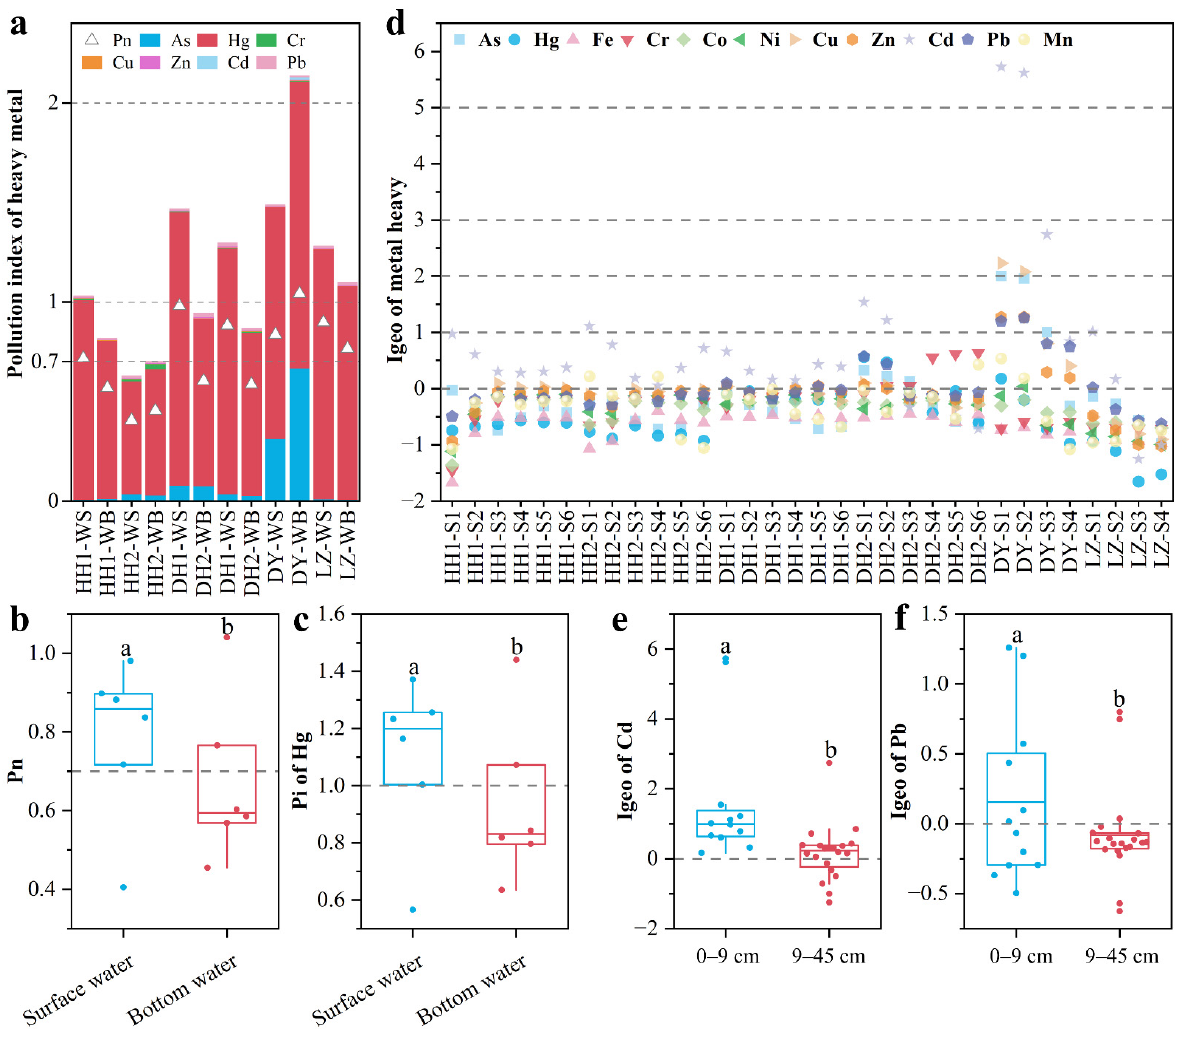
Figure 4. Pollution level of heavy metals: ( a ) pollution level of heavy metals in water columns; difference in P n ( b ) and P i for Hg ( c ) between surface water and bottom water; ( d ) pollution level of heavy metals in sediment cores and the difference in I geo for Cd ( e ) and Pb ( f ) within sediments at 0–9 and 9–45 cm. Different letters (a or b) represent statistically significant differences at the p < 0.05 level. The gray dotted line represents the pollution threshold of heavy metals: 1 and 2 represent slight and moderate pollution levels of specific heavy metal ( P i ) in water, respectively; 0.7 represent slight pollution level of all heavy metals ( P n ) in water; 0, 1, 2, 3 and 5 represent slight, moderate, moderate to heavy, heavy, and extreme pollution levels of heavy metals in sediments,